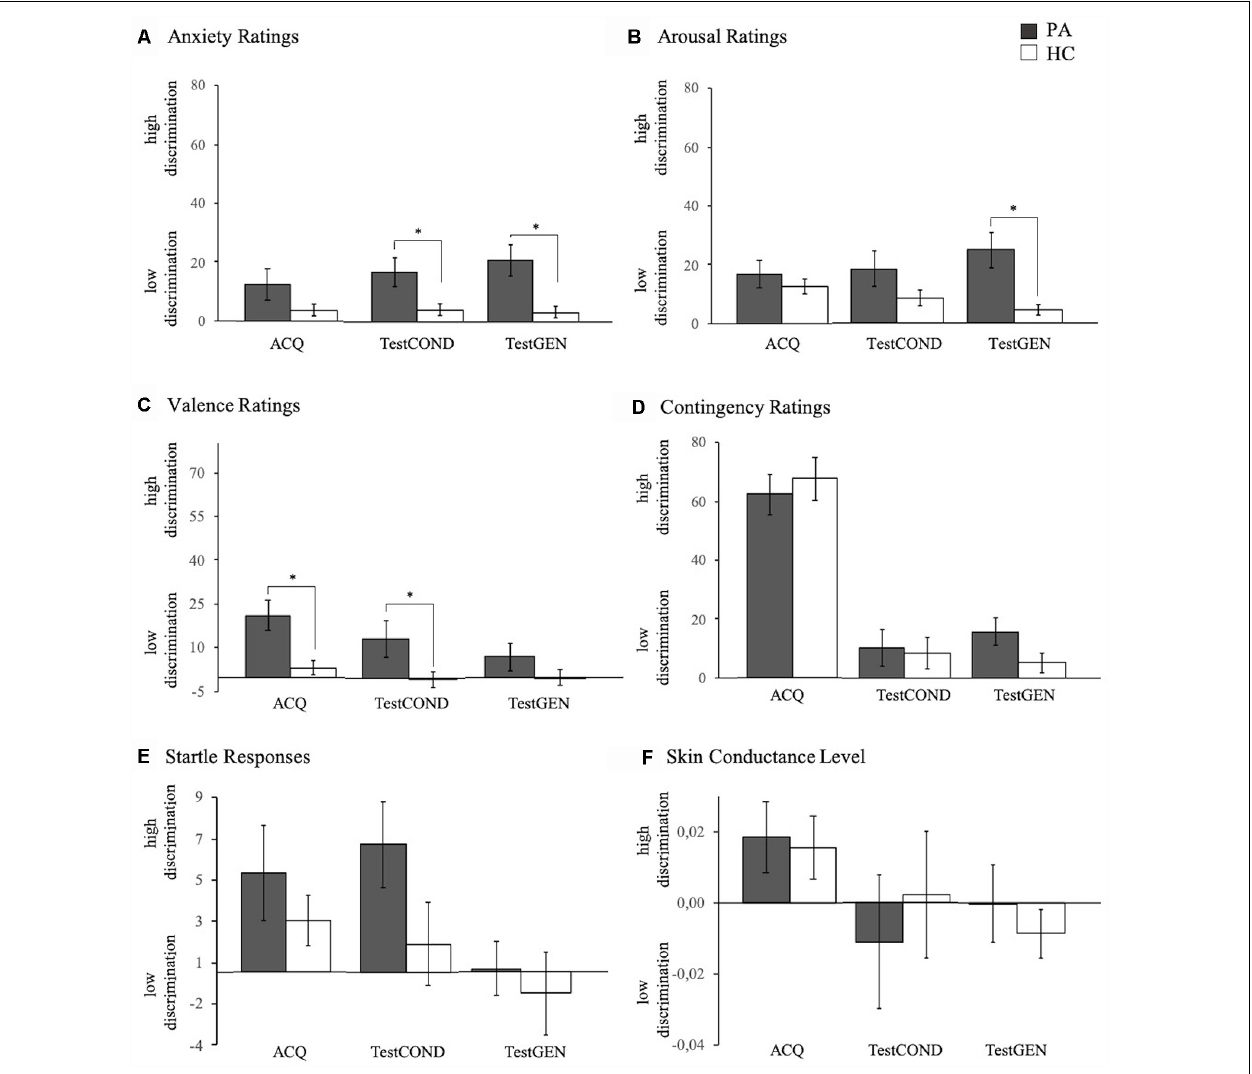
FIGURE 4 | Anxiety (A) , arousal (B) , valence (C) , and contingency (D) ratings as well as startle amplitude (E) and SCL (F) of participants with PA (gray) and HC (white) during the acquisition phase and the generalization test phase. Depicted are mean differential responses (means and standard errors) relative to CTX −